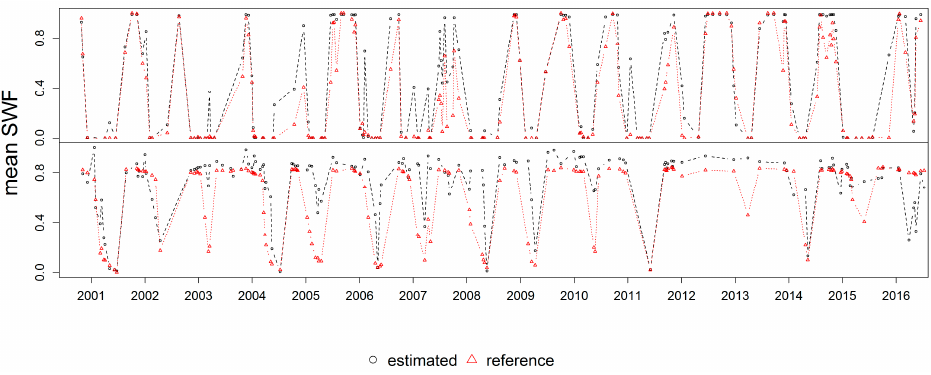
Figure 8. Time series of mean estimated and reference SWF over two gage sites in the Everglades.